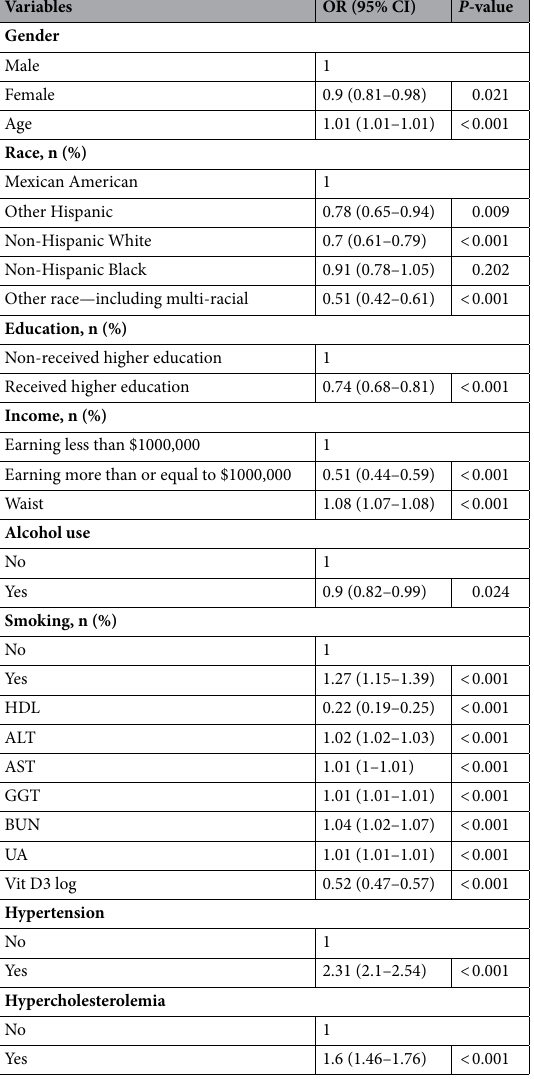
Table 2. Univariate analysis for insulin resistance. BMI body mass index, HDL high density lipoprotein, TBIL total bilirubin, ALB albumin, ALT alanine aminotransferase, AST aspartate aminotransferase, BUN blood urea